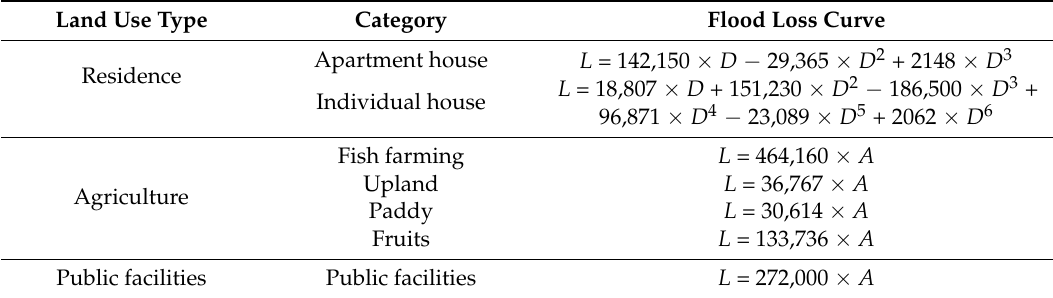
Table 3. Direct flood loss estimation equations of various land use types for Tainan City.